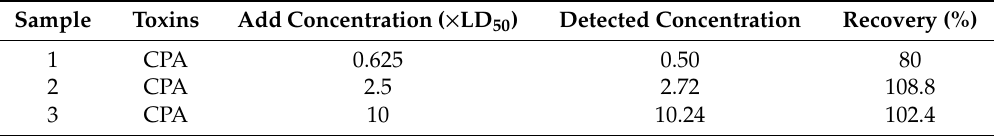
Table 3. Recovery rates of di ff erent alpha toxin concentrations in milk